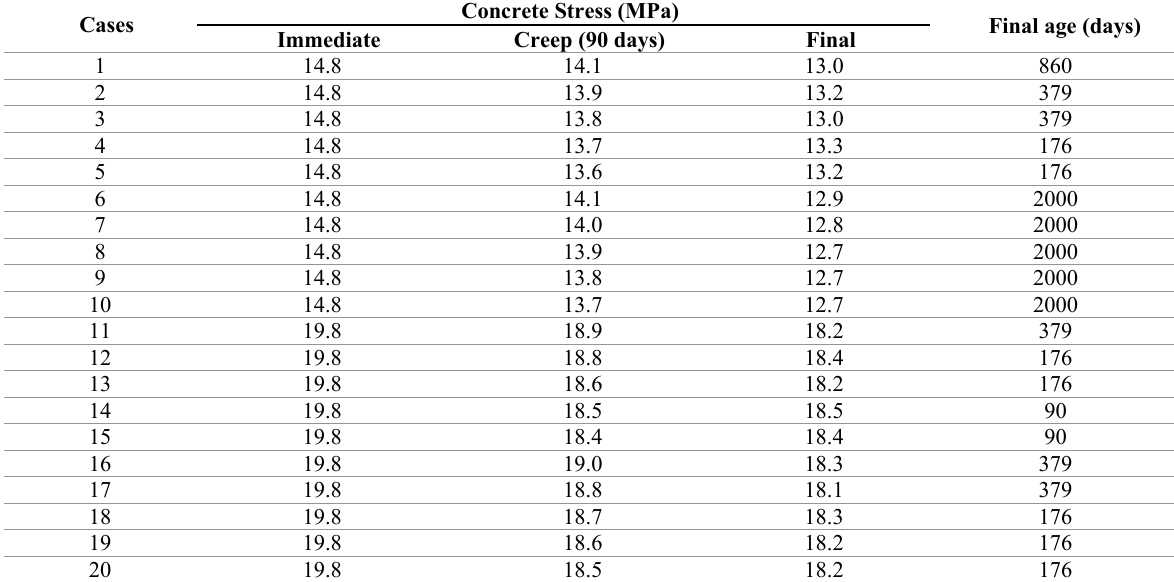
Table 3. Stresses on the mass of concrete.